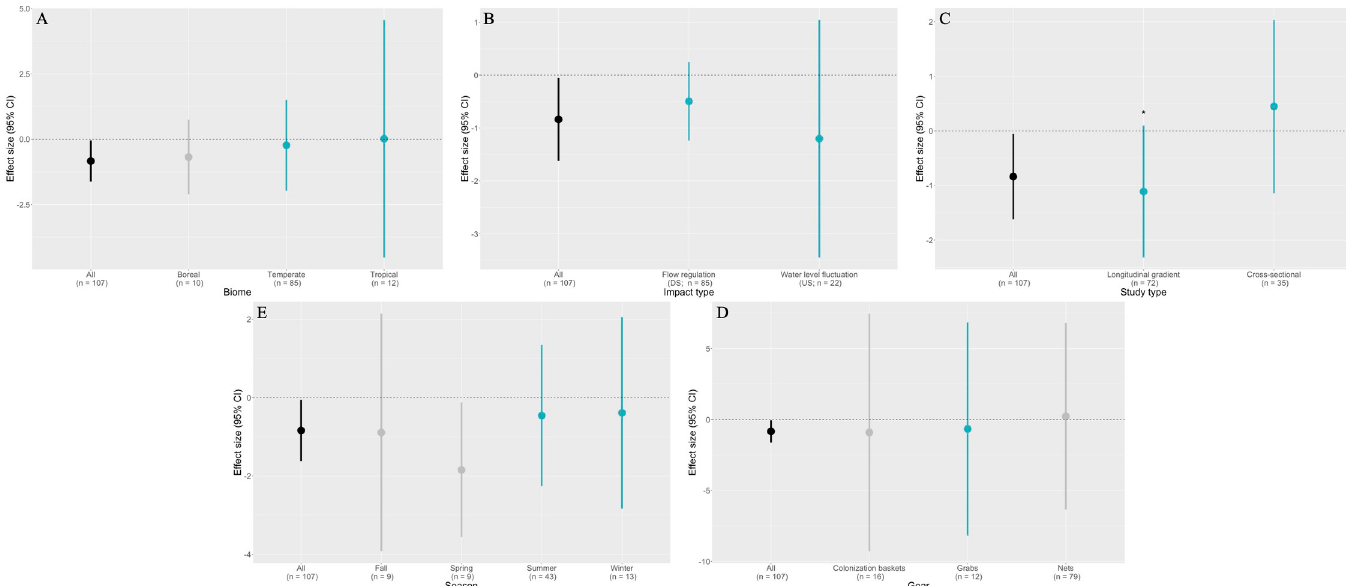
Fig 4. Plots showing the mean effect sizes and their confidence interval for each of the moderators. Value in black is the mean effect size of the meta-analysis and the other colors are related to the different effect sizes when including specific moderators. When in grey, statistical significance of moderator cannot be interpreted with confidence due to statistical power issues (df s insufficient). When effect size is in color (i.e., blue) statistical interpretation can be made with confidence, whether it is significant or not (sufficient df s ). Asterisk signifies statistically marginally significant